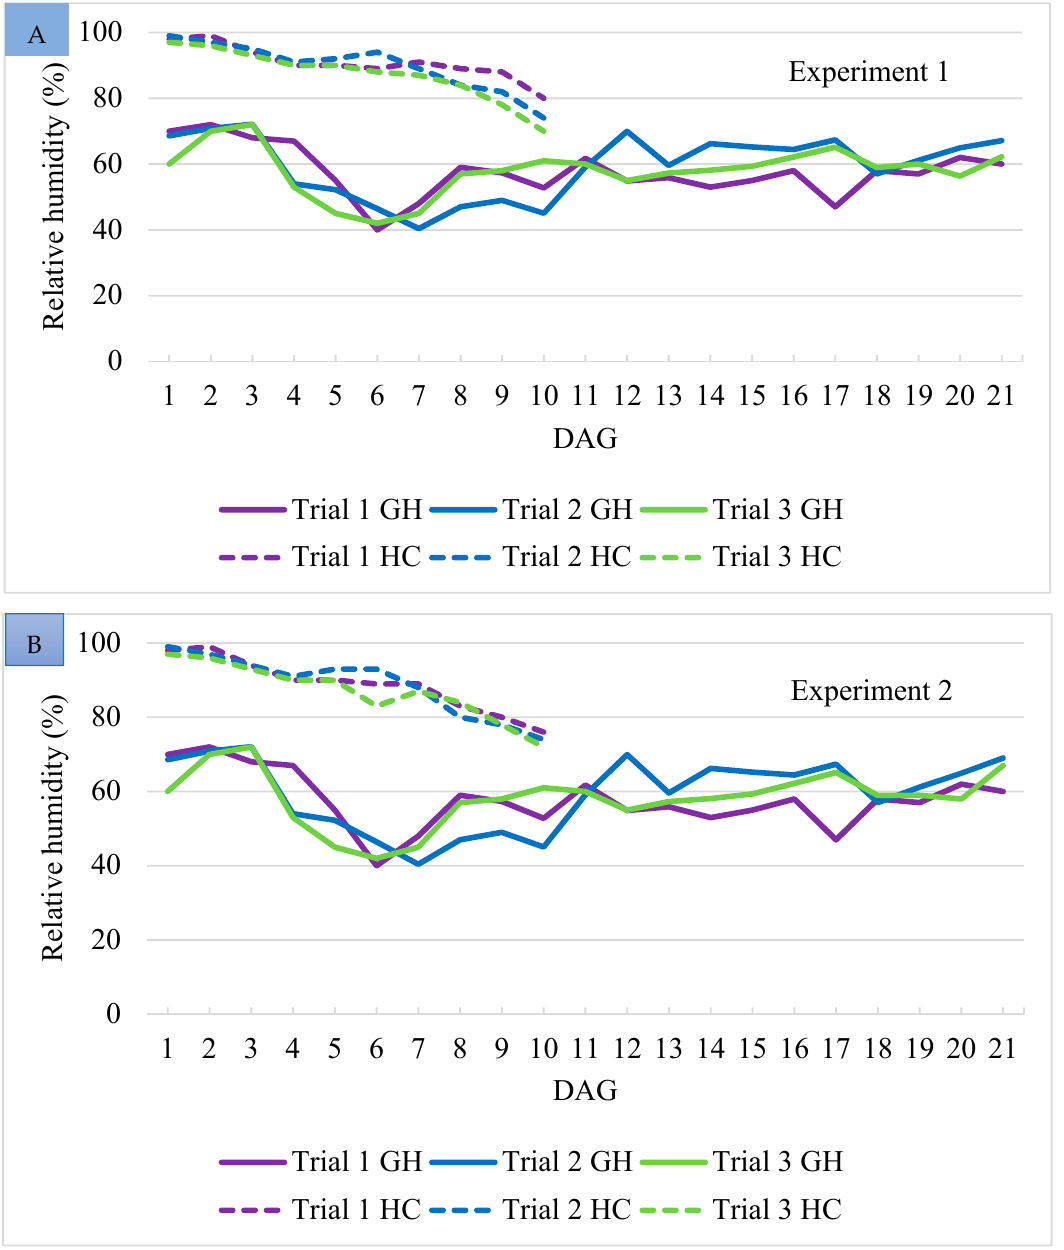
Figure 2. Relative humidity (%) in the healing chamber (HC) for 10 days after grafting (DAG) and in the greenhouse (GH) for 21 DAG for trials 1, 2, and 3 on 5 March, 15 March, and 23 April 2020, respectively, for experiment 1 ( A ), and for trials 1, 2, and 3 on 19 August, 14 October, and 10 November 2020, respectively, for experiment 2 ( B ) at Mount Vernon, WA, USA. Data were recorded every 15 min (Onset HOBO, Bourne, MA, USA).